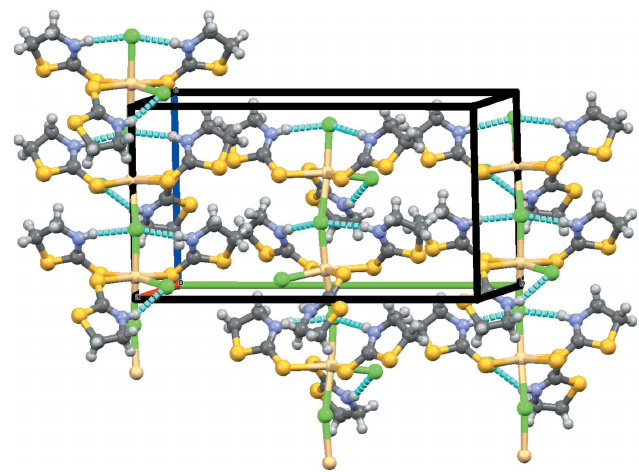
Figure 1 The asymmetric unit of title compound with displacement ellipsoids drawn at the 50% probability level.